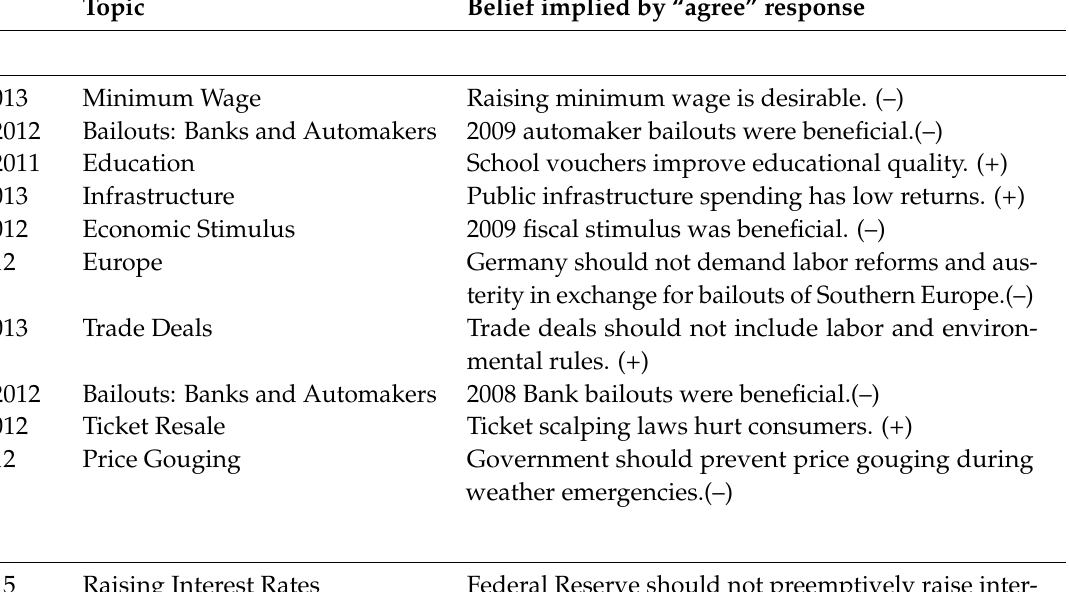
Table 1: IGM panel items related to latent ideology.